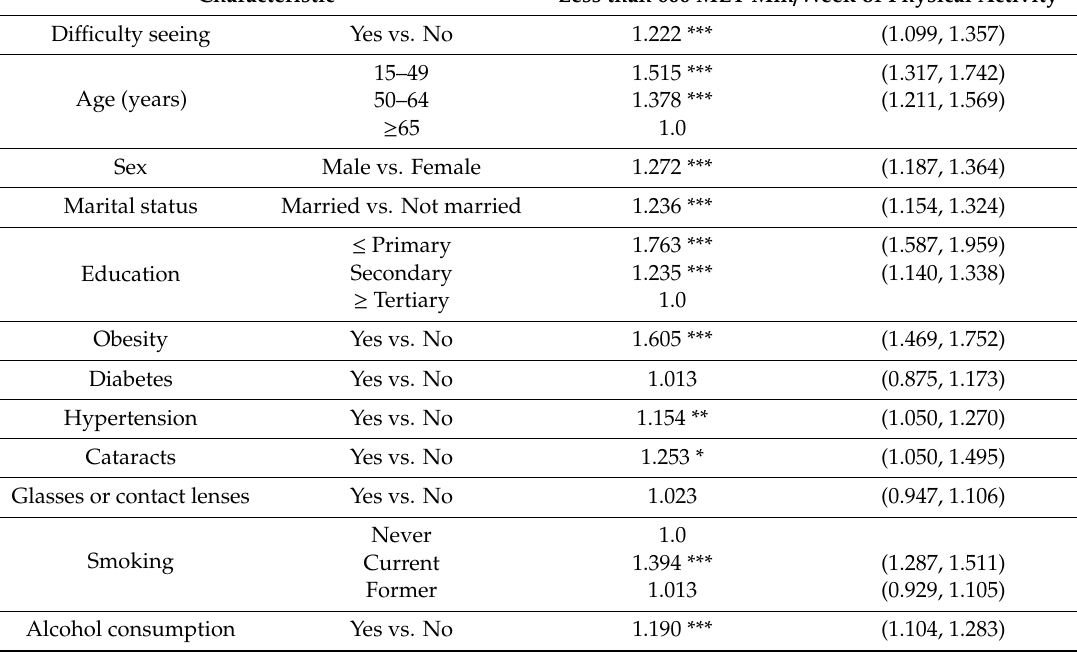
Table 2. Association of di ffi culty seeing and other covariates with physical activity (outcome) estimated by multivariable logistic regression. ( n = 17,777).